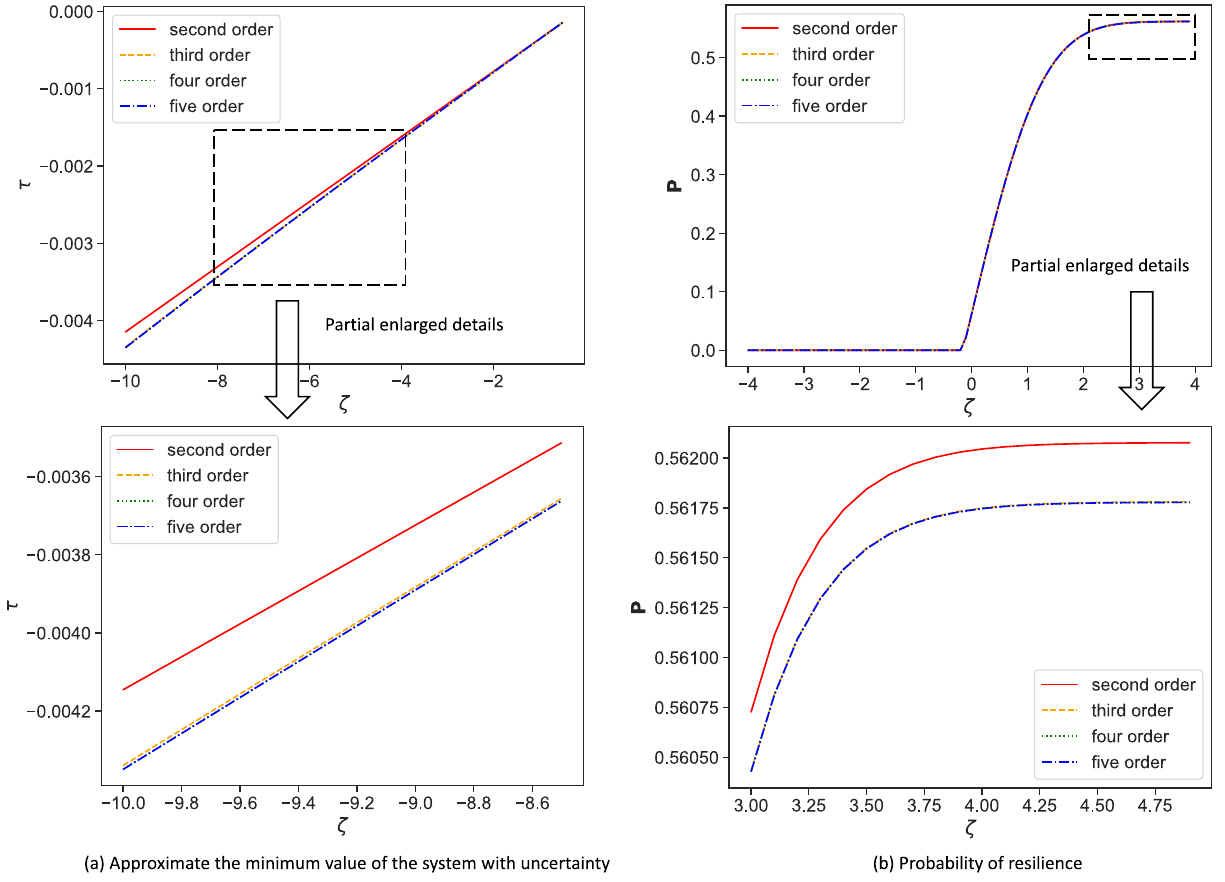
Figure 6. Approximate resilience of system by Polynomial Chaos Expansion. We truncate the series to order r from 2 to 5. ( a ) Approximate the minimum value of the system by PCE. ( b ) Approximate the probability of resilience. It is clear that there is a significant difference in results between r = 2 and r = 3, 4, 5 in ( a ) and ( b